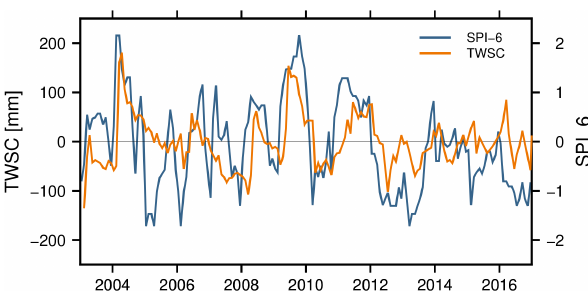
Figure 1. Detrended and deseasoned GRACE-TWSC [mm] (or- ange) and the SPI [–] for 6 months of accumulated precipitation (blue), spatially averaged for Ceará,